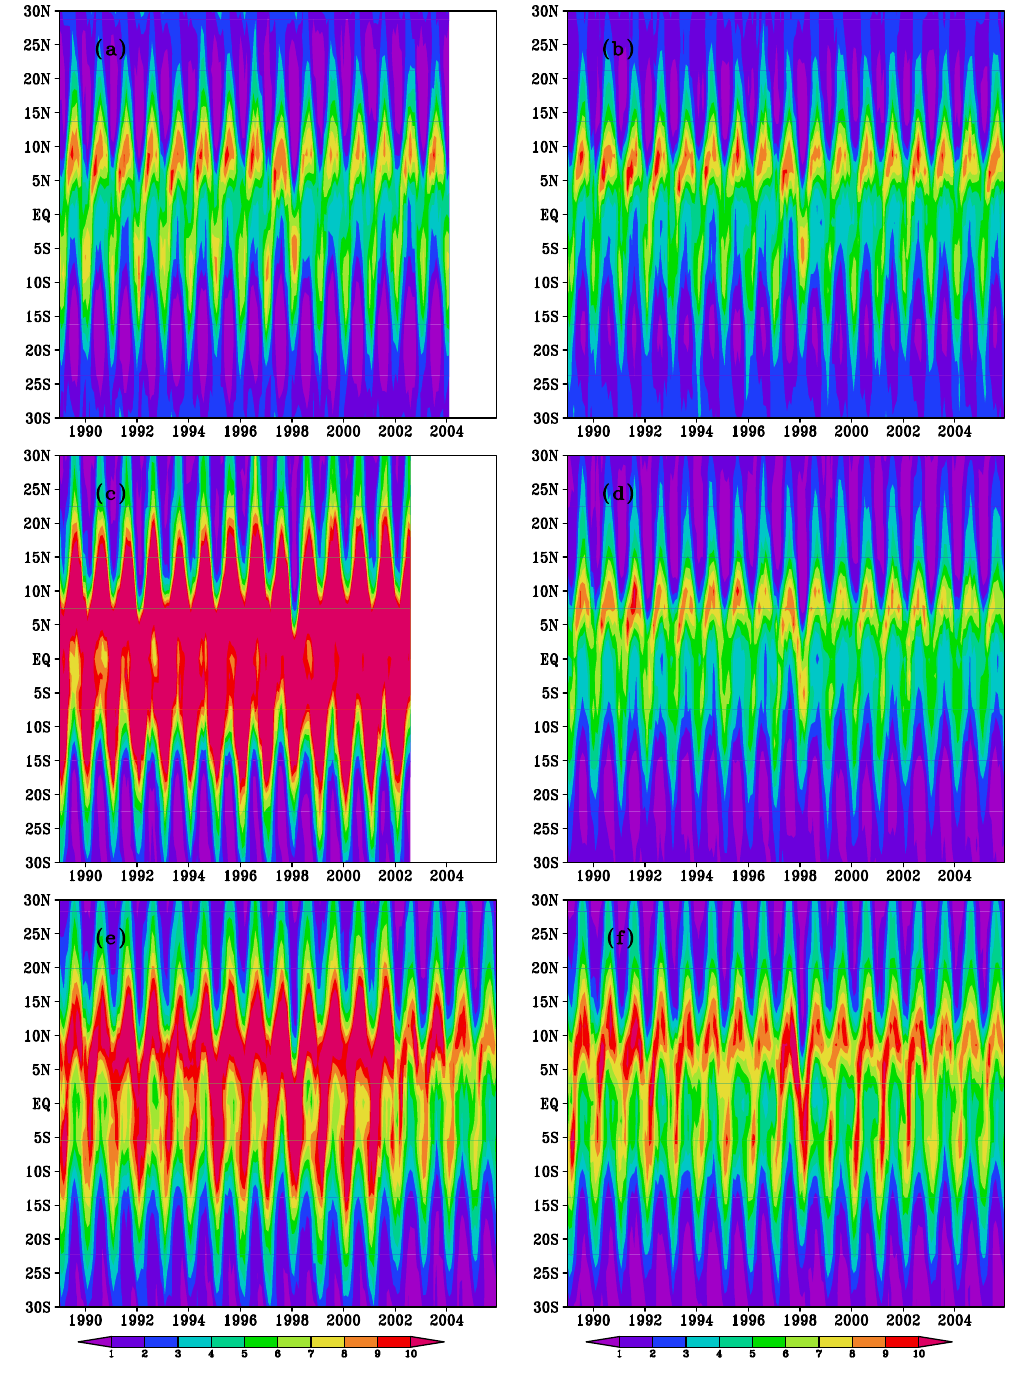
Fig. 10. Zonal mean convective precipitation (mm/day) from (a) GPI data, (b) CMAP data, (c) ERA-40 reanalyses, (d) ERA-Interim reanalyses, (e) run “A E40”, and (f) run “B EI”. run “B EI” which was forced by ERA-Interim, but both runs significantly underestimate precipitation in the